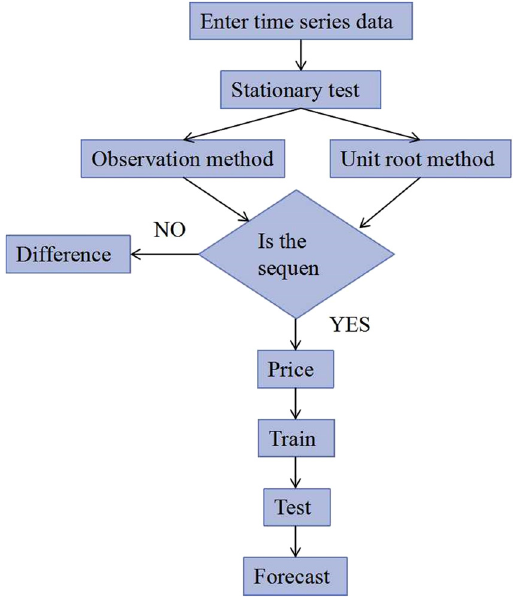
Figure 1: Time - series prediction fl ow.